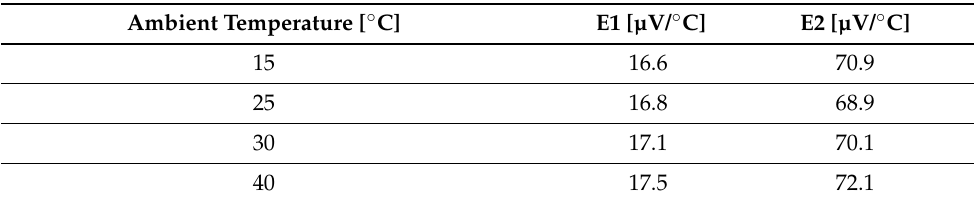
Table 3. Proposed thermopiles’ measured sensitivity for a 10 cm × 10 cm black body source at 10 cm distance.